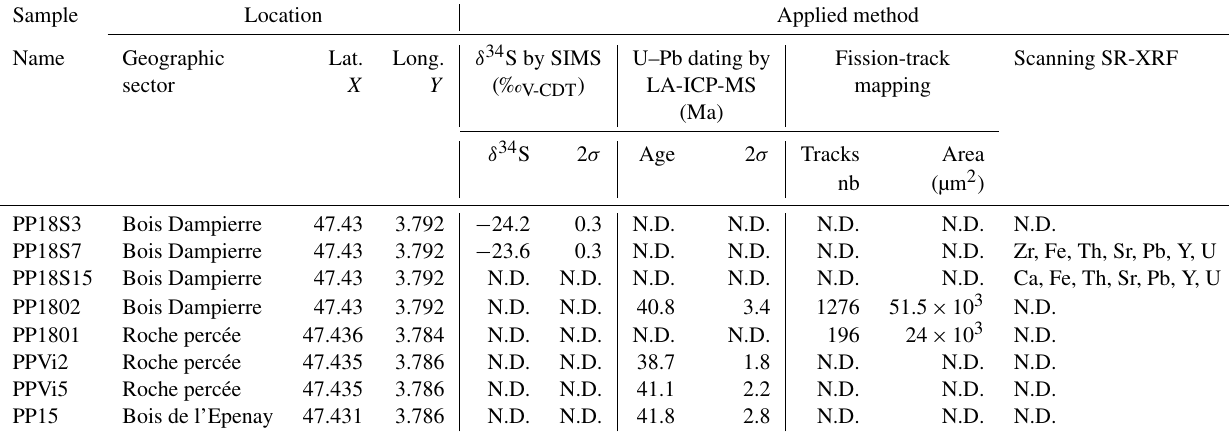
Table 1. Sample location, sulfur stable isotopic composition of pyrite, fluorite U–Pb age, fission track and scanning SR-XRF of fluorite (N.D. – not